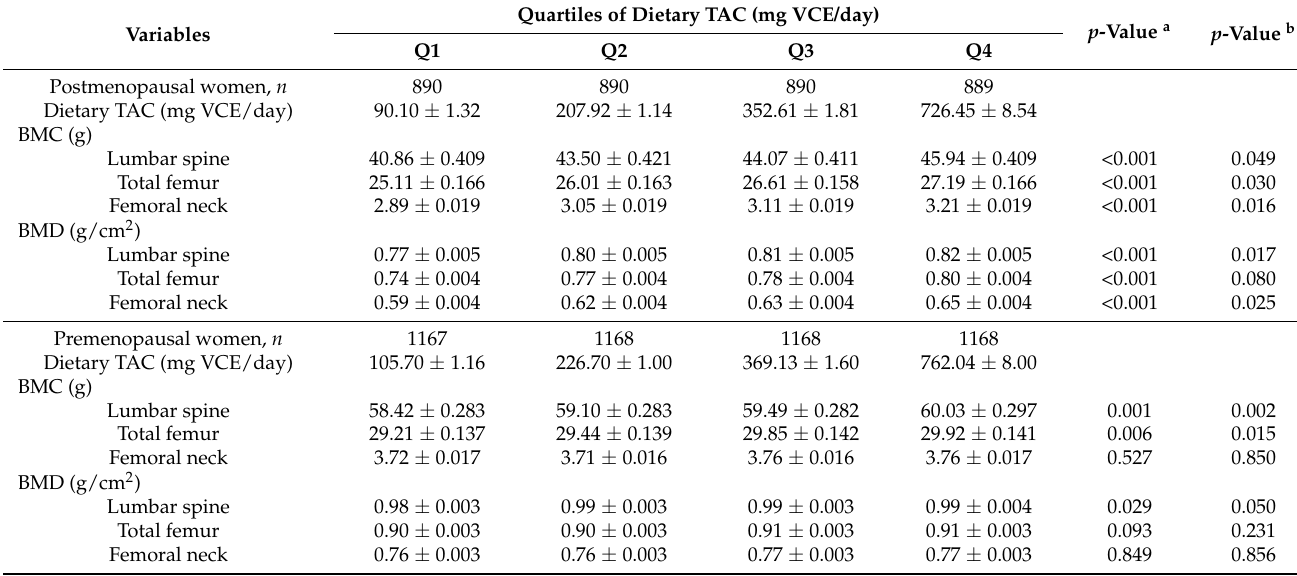
Table 4. Bone mass according to quartiles of dietary total antioxidant capacity (TAC) in the study population.